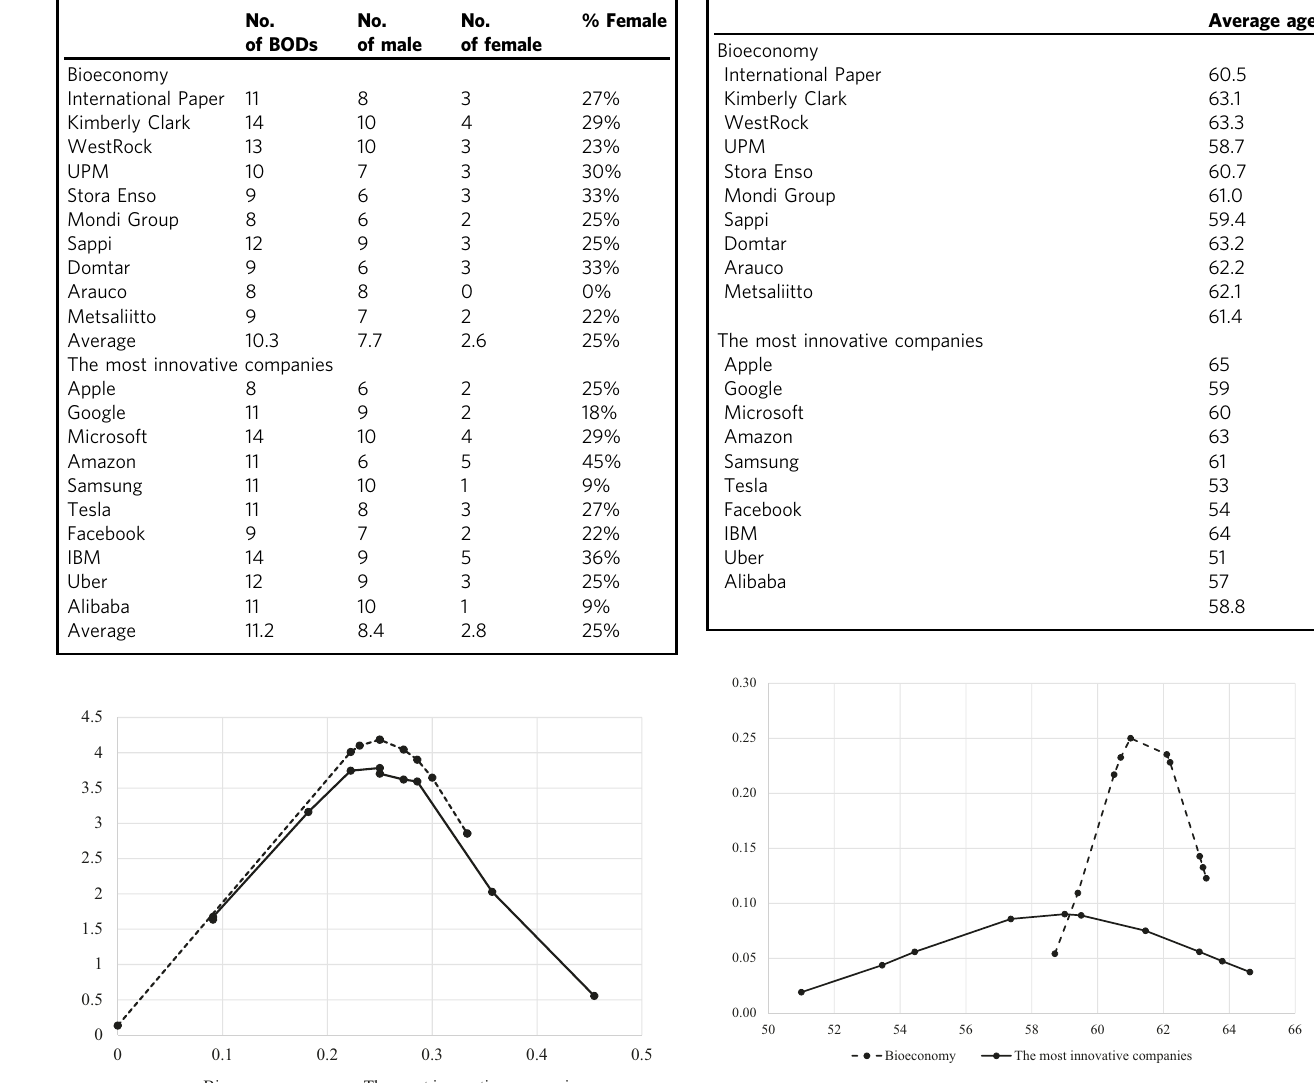
Fig. 5 Normal distribution of age in the bioeconomy and the most innovative companies. Age diversity in bioeconomy (dotted line) versus the most innovative companies (solid line). More narrow age spread is observed in case of the bioeconomy